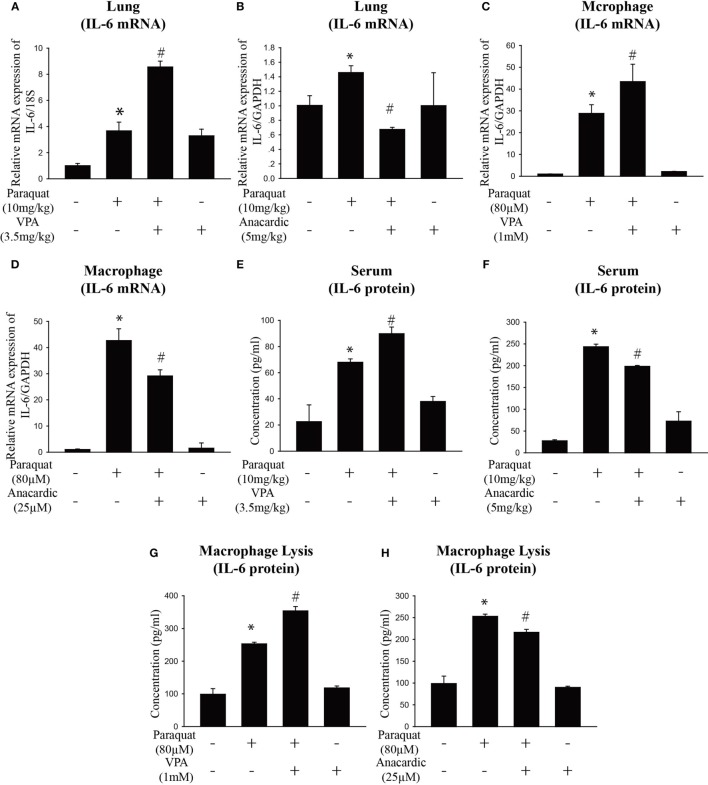
Histone acetylation regulates IL-6 expression. (A,B) Wild-type C57BL/6 male mice were treated with vehicle (saline) or 10 mg/kg of paraquat (PQ) for 3 days, and mice received VPA (3.5 mg/kg) or anacardic acid (5 mg/kg) starting 24 and 1 h before PQ injection. IL-6 mRNA expression was determined by real-time PCR. (C,D) Macrophages were treated with vehicle or PQ (80 µM) for 24 h, and cells received VPA (1 mM) or anacardic acid (25 µM) starting 1 h before PQ treatment. IL-6 mRNA expression was determined by real-time PCR. (E–H) ELISA measurement of IL-6 in serum of day 3 mice and in lysates of macrophages in the above mentioned experimental groups. Data are expressed as means ± SEM, *P < 0.05 versus vehicle and #P < 0.05 versus PQ (n = 4–6).